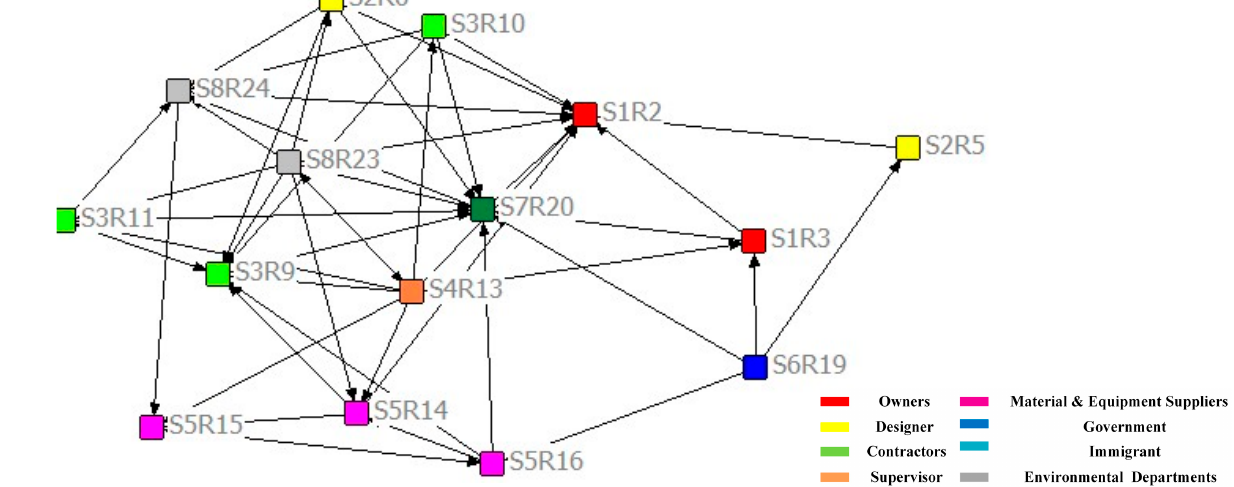
Figure 7. Stakeholder behavioral risk network after the elimination of core risks. After the core behavioral risk factors and key relationships were controlled, the overall network effect was tested in terms of network density, clustering coefficient, intermediate central potential, and network accessibility, and the specific results were as